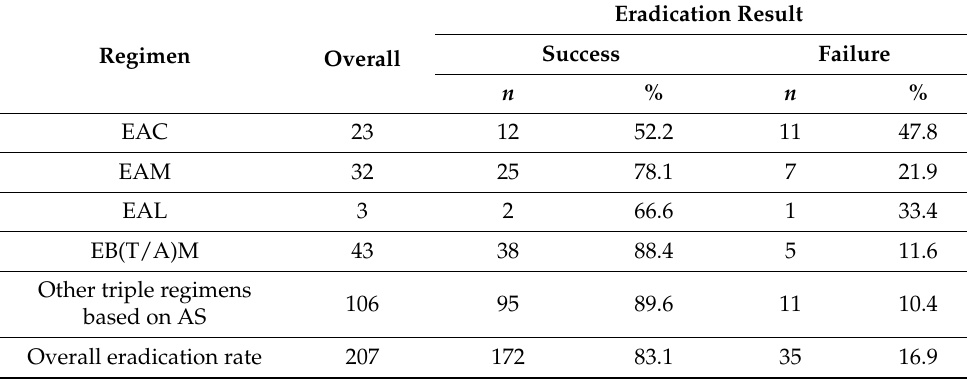
Table 4. Helicobacter pylori eradication regimens and